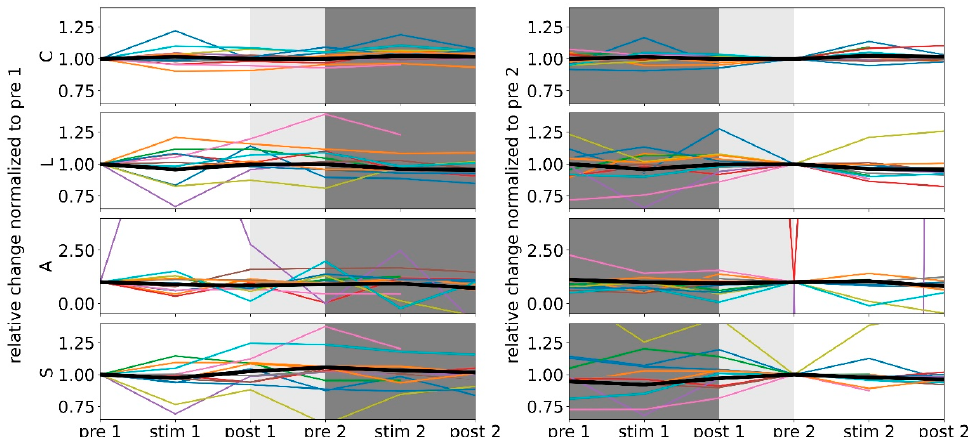
Figure 3. Relative changes of global network characteristics (average clustering coefficient C , average shortest path length L , assortativity A , and synchronisability S) of all responders (colour-coded). Group medians are shown in black, and all lines are for eye-guidance only. Data normalized to the respective values from the morning pre-stimulation phase ( left ; white-shaded area) and from the afternoon pre-stimulation phase ( right ; white-shaded area). Light-grey shaded area marks the break between the two 3 h examination phases. The different scaling of the y-axis for assortativity is due to the fact that this characteristic only rarely deviated from − 0.02 which resulted in anomalous large relative deviations. We note that we obtained for the vast majority of investigated networks, indications for a random topology (their assortativity values were confined to the range of A values derived from 1000 random networks with the same number of vertices and edge densities as the evolving functional brain networks).